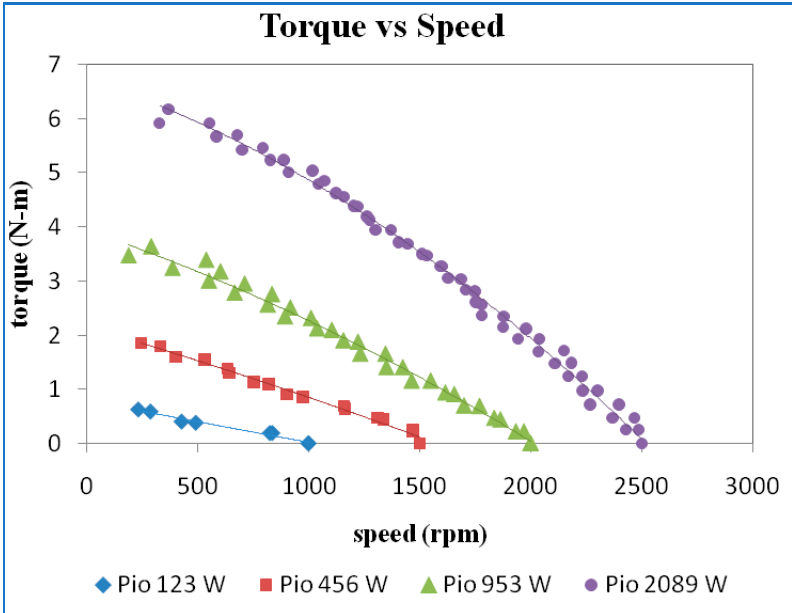
Figure 13. Torque vs. speed at a guide vane opening of 13 mm.